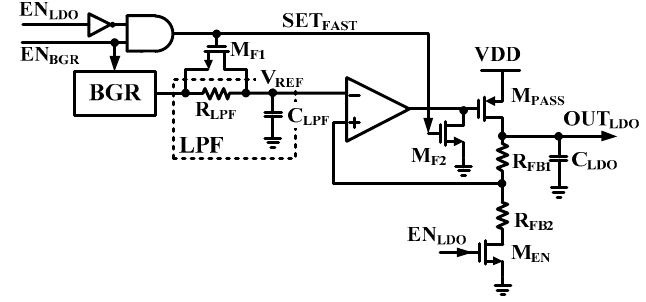
Figure 18. Block diagram of low noise LDO with a fast settling technique.